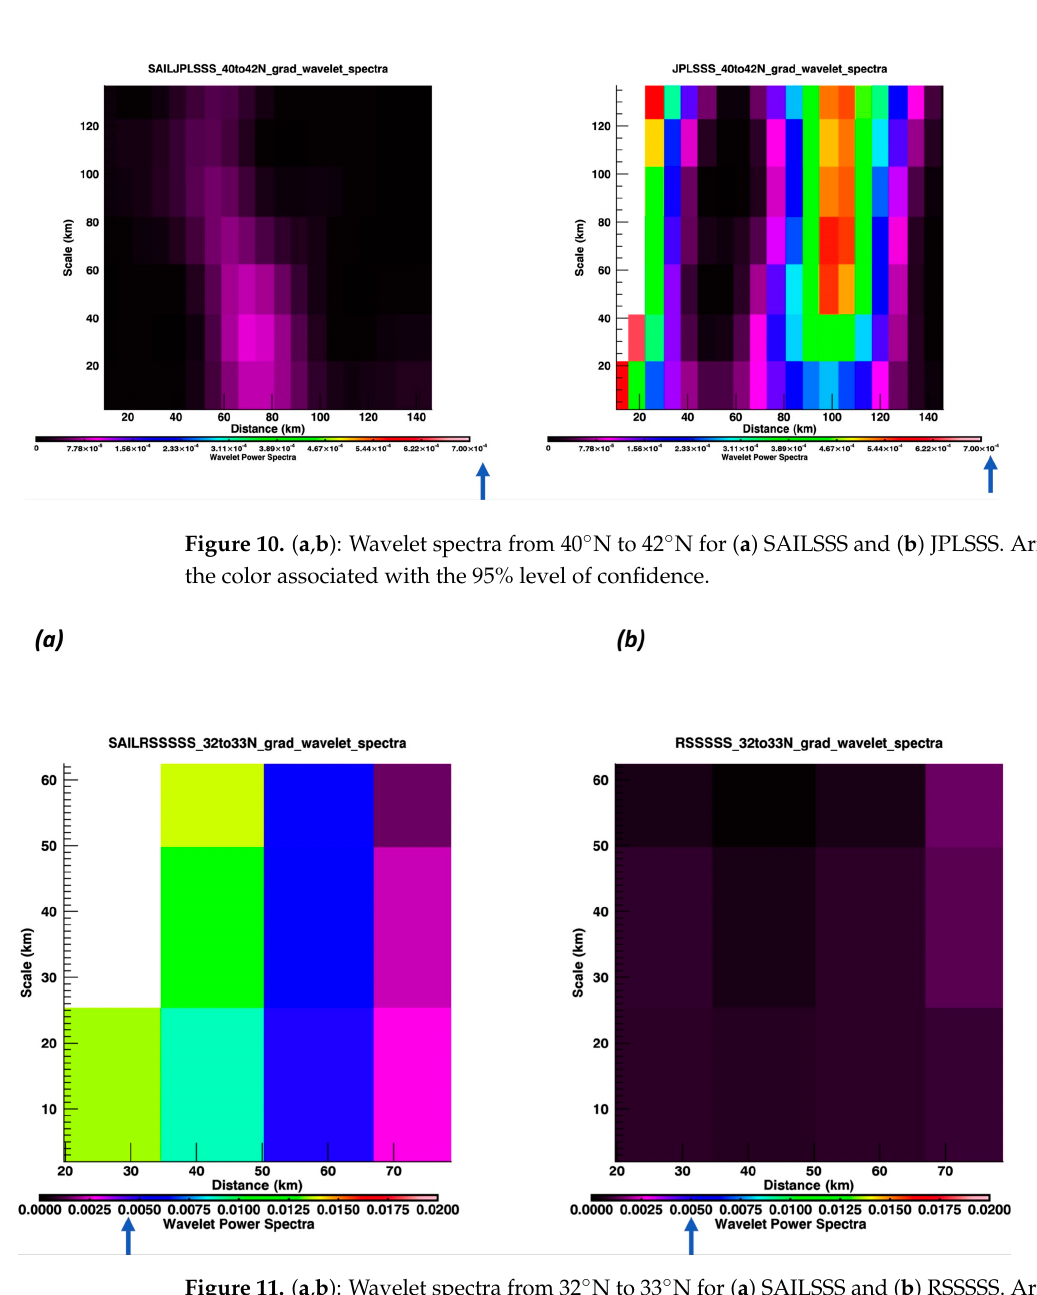
Figure 12. ( a , b ). Wavelet spectra from 38°N to 40°N for ( a ) SAILSSS and ( b ) RSSSSS. Arrows indicate the color associated with the 95% level of confidence.